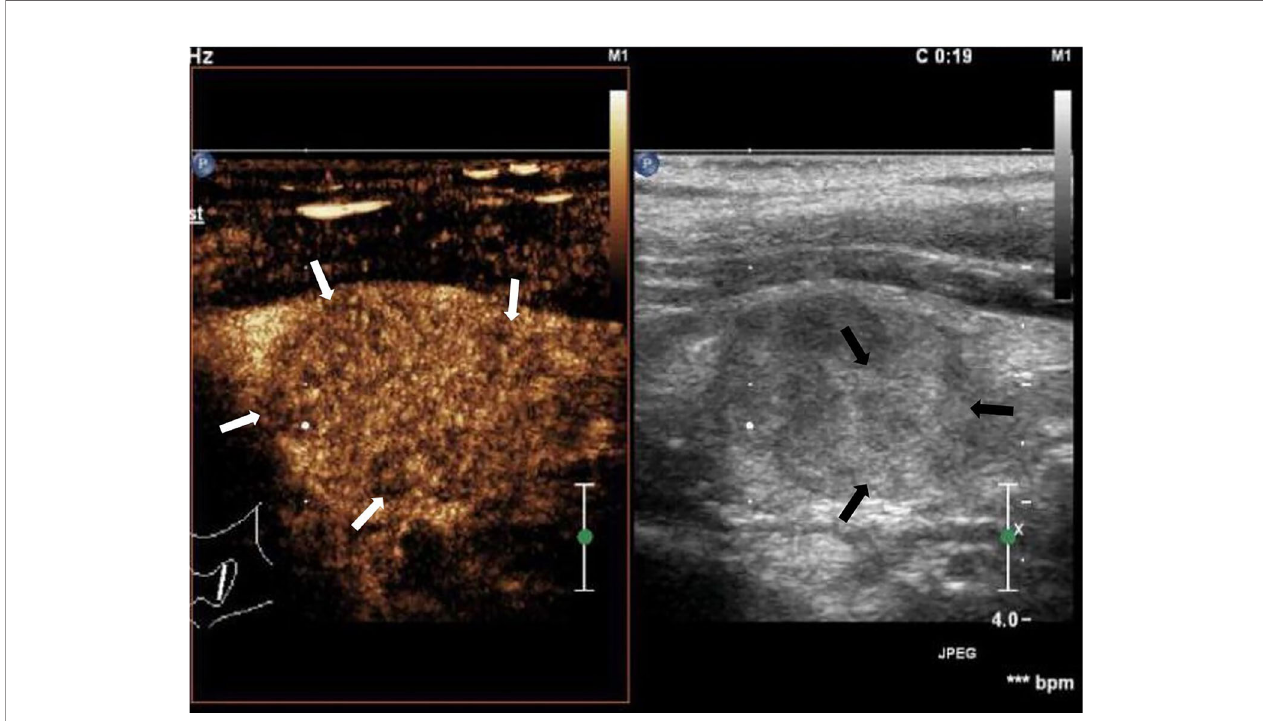
FIGURE 1 | Cervical lymph node metastasis of papillary thyroid carcinoma: lymph node enlargement, absent hilum, heterogeneous, hyperechoic islands (black arrow). Asynchronous enhancement in arterial phase of lymph nodes (white